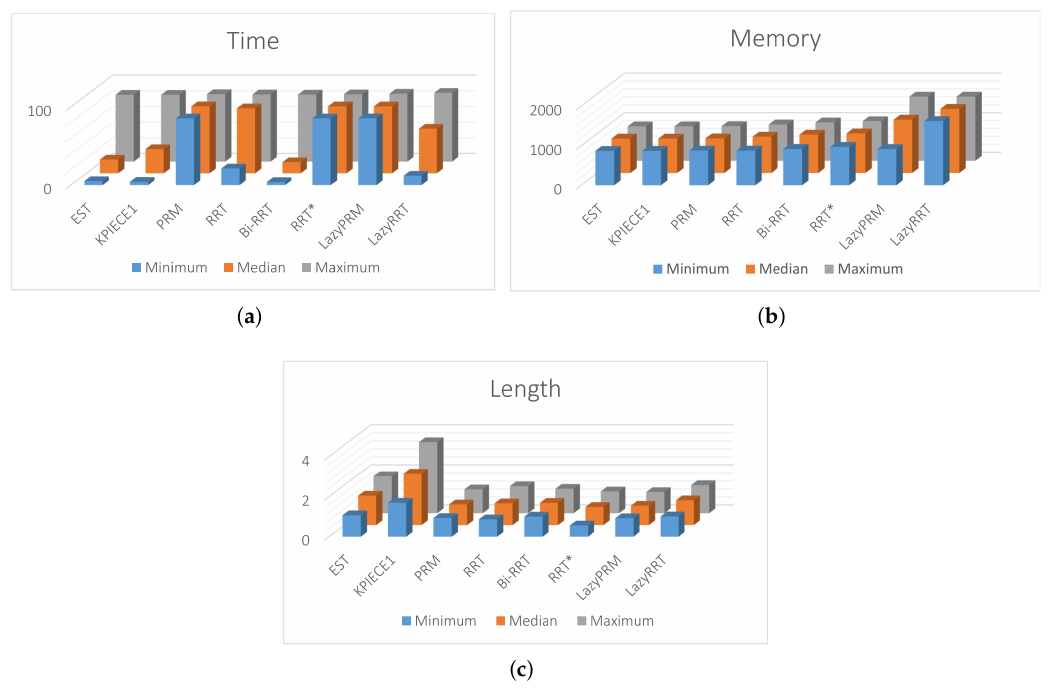
Figure 30. Bar graphs for time, length of path, and memory in number of times respect to the MGHPPM results of case 1. ( a ) Execution time. ( b ) Memory. ( c ) Length of path.